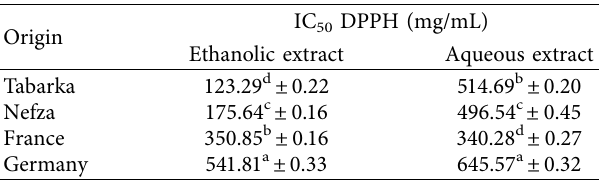
Figure 4: IC 50 of the ethanolic extract according to the origin of M. officinalis and seeds. Values followed by the same letters are not significantly different ( P > 0 . 05). Table 7: DPPH radical scavenging capacity (IC 50 ) of ethanolic and aqueous